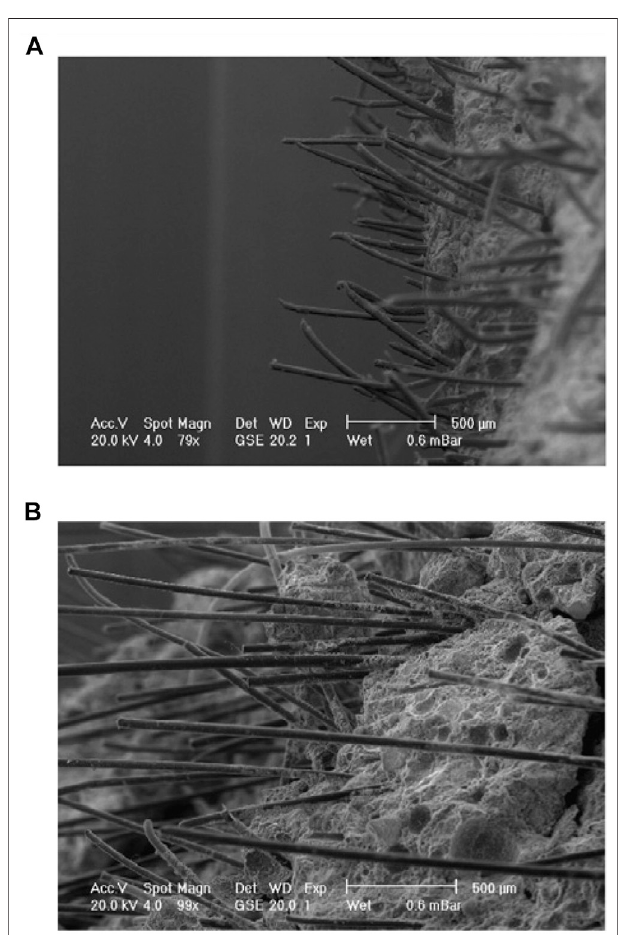
FIGURE 3 | Comparison of pullout lengths of fi bers embedded in the cementitious materials under (A) monotonic loading, and (B) cyclic loading (Mechtcherine et al.,